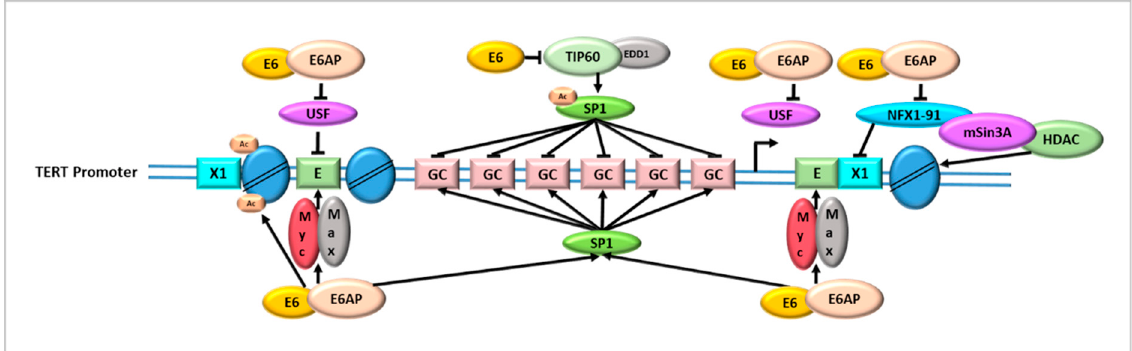
Figure 1. The main strategies adopted by HPV E6 to regulate telomerase activity at transcriptional level relies on the ability of HPV E6/E6AP complex to stabilize MYC/MAX and SP1 transcription activators, to dislocate USF and NFX1-91 transcription repressors, to induce the acetylation of his- tone H3 and to inhibit TIP60-mediated acetylation of